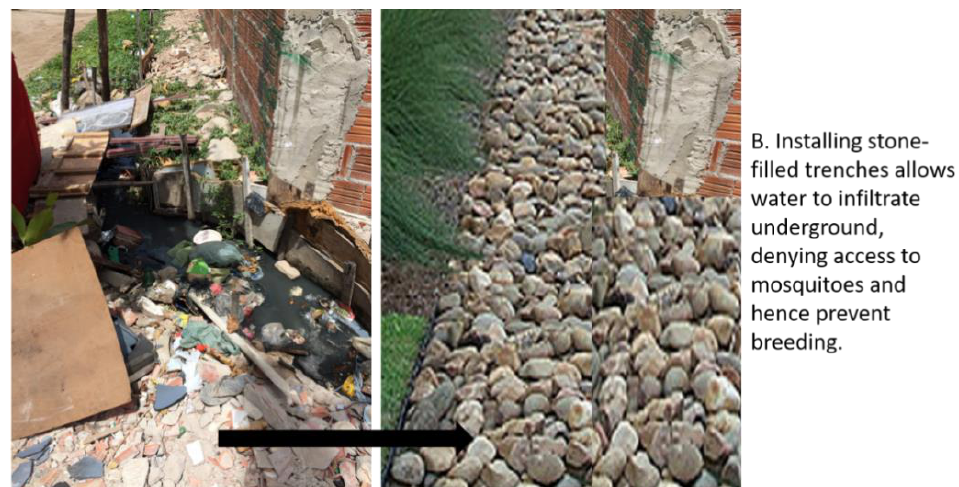
Figure 5. ( A ) Accumulation of standing water in solid waste around a favela dwelling; installing a stone-filled trench; ( B ) has the potential to deny mosquitoes access to water in which they could breed.